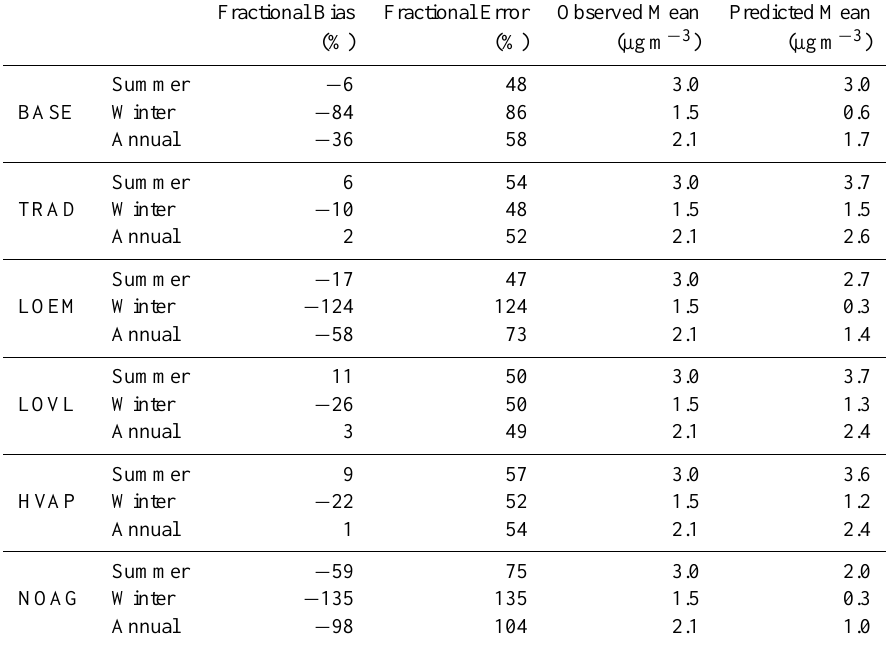
Table 5. Statistical metrics to evaluate comparison between model results from BASE, TRAD, LOEM, LOVL, HVAP and the IMPROVE network for summer, winter and the entire